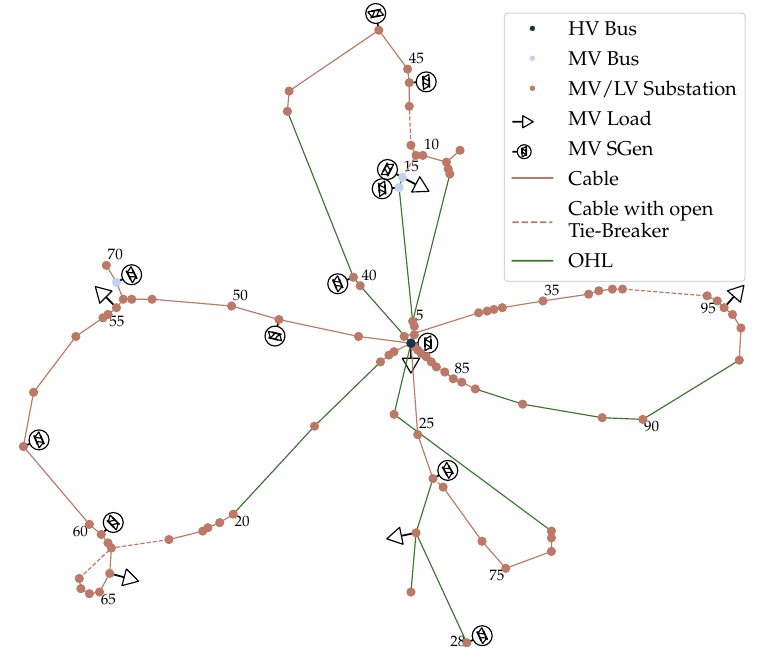
Figure 5. Rural MV grid